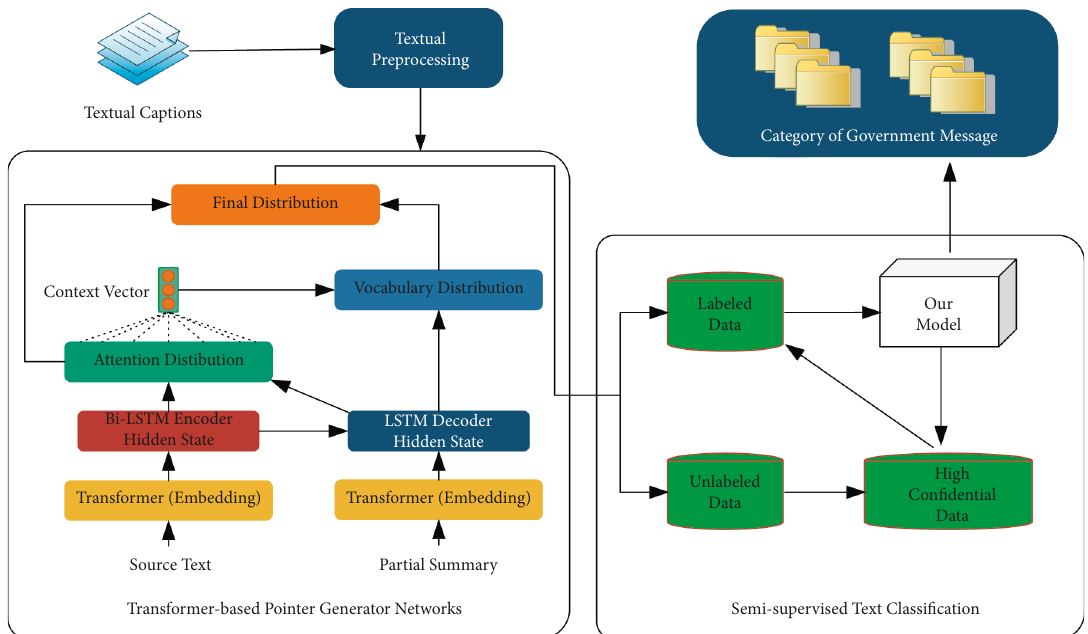
Figure 1: Framework for feature extraction and the semisupervised method for government message text